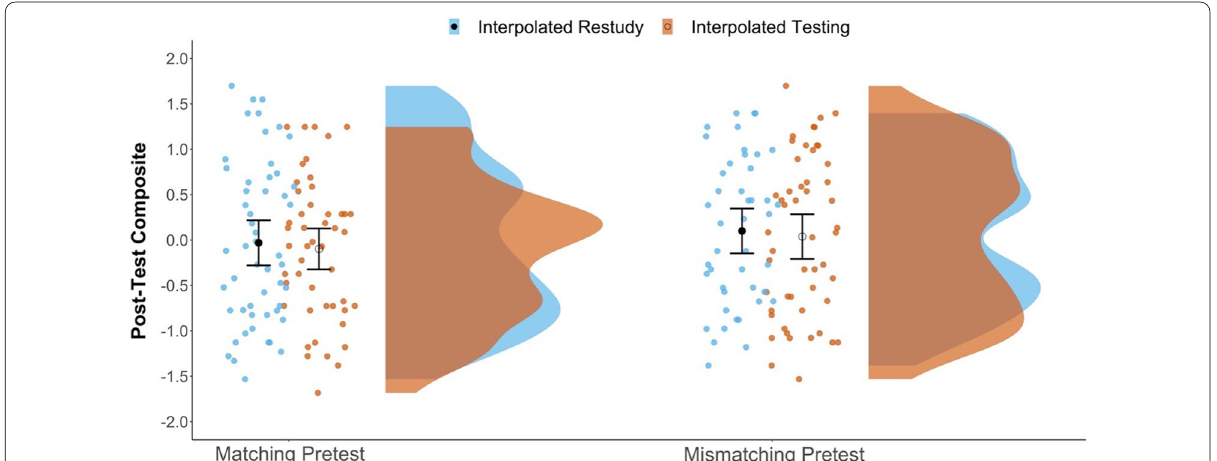
Fig. 6 Raincloud plots depicting differences in posttest performance between conditions. Dots represent individual subject means in each condition. The closed black dots represent group-level mean estimates for the Restudy conditions; open circles represent the group-level mean estimates for the Testing conditions. Error bars are 95% confidence